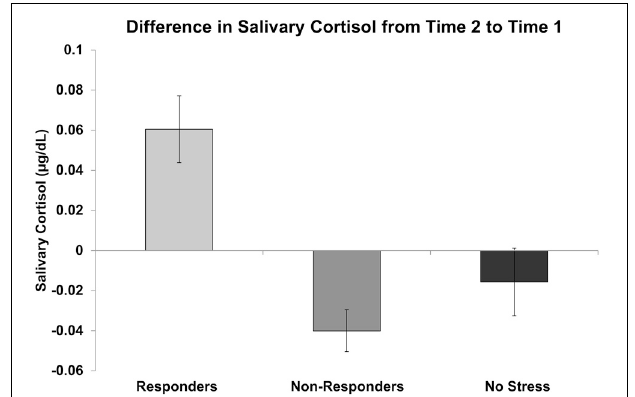
FIGURE 3 | Difference in salivary cortisol levels ( µ g/dL) from time 2 (prior to the third conditioning task run) to time 1 (baseline) for cortisol responders, non-responders, and no stress